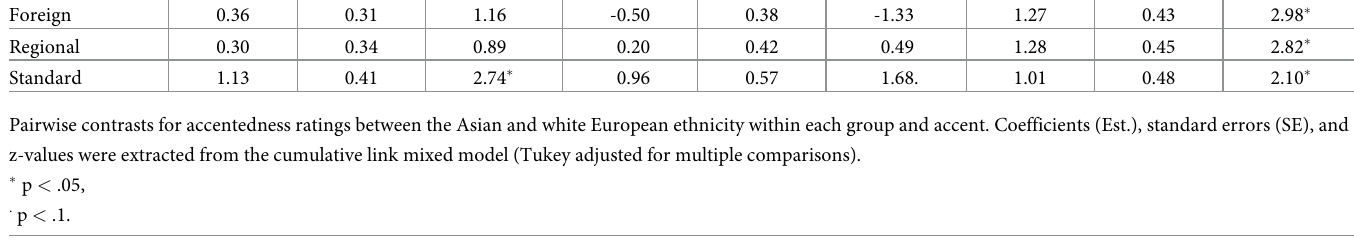
Table 3. Pairwise contrasts for accentedness ratings.